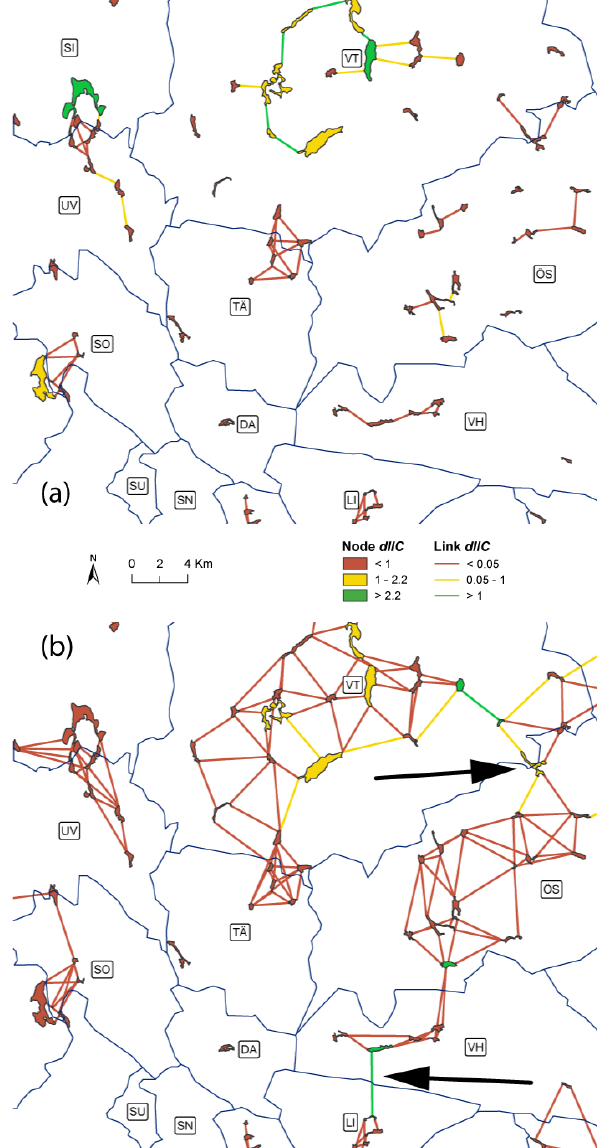
Fig. 2 . The wetland network in a part of the study area, for d = 2 km (a) and d = 4 km (b). Our fit analysis uses the sum of the dIIC values of all elements (wetlands and wetland links) crossed by each boundary between two municipalities. Two arrows point out a node and a link that have a potential strong influence on wetlands in two municipalities. These particular elements are also potential cross-scale bridges between a local wetland cluster and the regional structure of wetland zones shown in Fig. 3. The names of the municipalities are abbreviated as follows: DA = Danderyd, LI = Lidingö, SI = Sigtuna, SO = Sollentuna, SN = Solna, SU = Sundbyberg, TÄ = Täby, UV = Upplands Väsby, VT = Vallentuna, VH = Vaxholm, ÖS = Österåker.